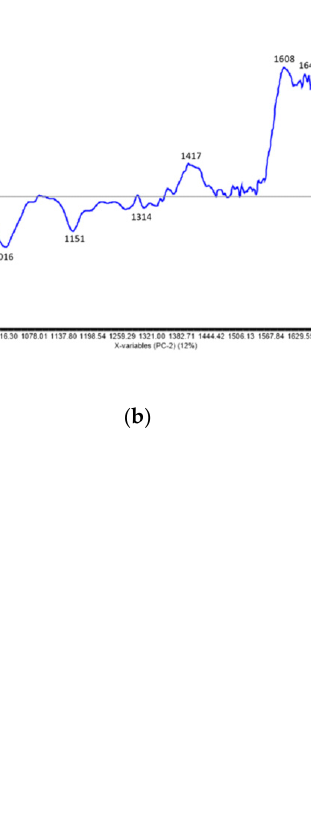
Figure 7. Principal component analysis (PCA) score 3D plots of PC-1 vs. PC-2 and PC-3 obtained for the 15 FT-IR spectra corresponding to the P1–P3 and H1–H12 samples, respectively: P1–P3 and H1– H12 are labelled for clear visualization.